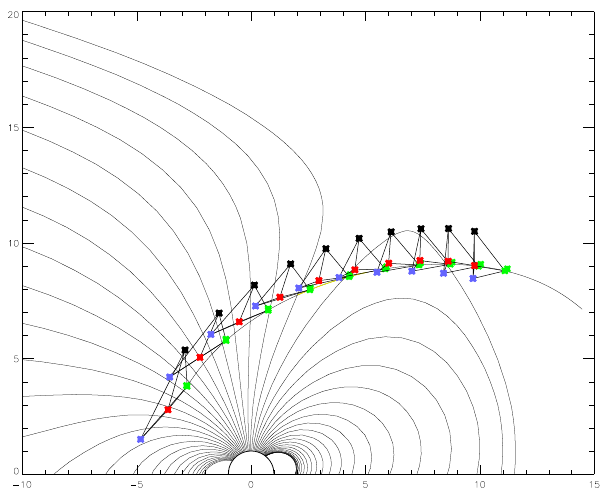
Fig. 3. Cluster tetrahedron formations at x-y, x-z, y-z-planes and in 3-D box (x, y, z) on 17 March 2001 at 05:00UT. In 2-D plots the aqua arrows indicate the background magnetic field direction and the blue ones the spacecraft velocity vector. In 3-D plot the aqua colored arrows denote the background magnetic field direction. For clarity, in all plots the distances between the spacecraft are a factor of 20 larger than in